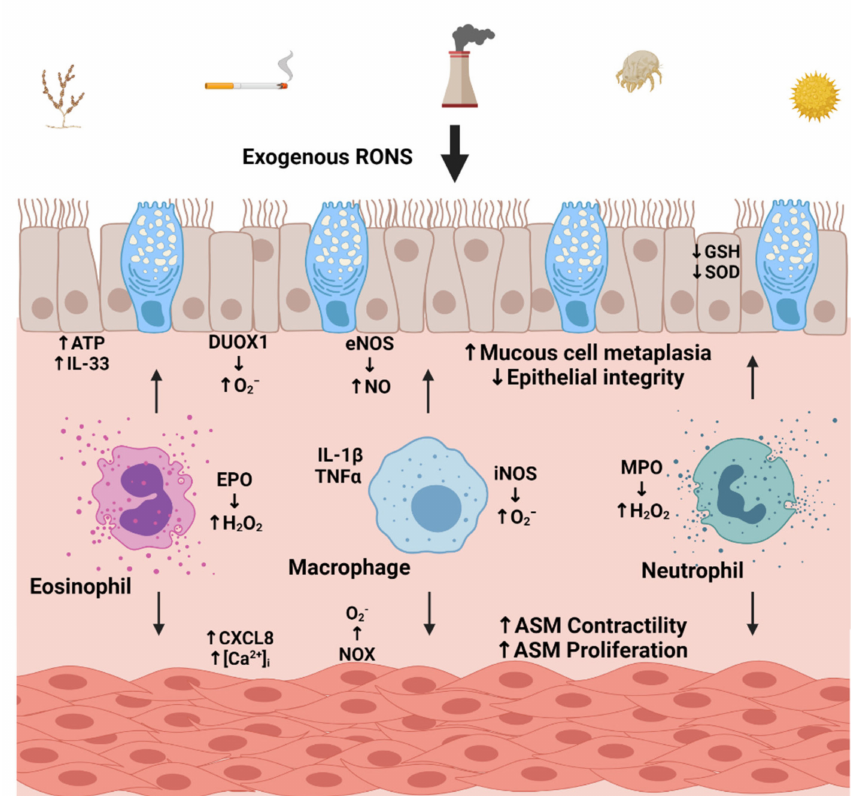
Figure 1. Effects of oxidative stress on airway inflammation. Environmental allergens, cigarette smoke, pollution, and pathogens interact with the airway epithelium, leading to increases in ex- ogenous or endogenous reactive oxygen and nitrogen species (RONS) levels and contributing to the pathogenesis of asthma and COPD. In response, the airway epithelium generates superoxide (O 2 − ) and nitric oxide (NO) and releases ATP and IL-33. Similarly, airway smooth muscle (ASM) release pro-inflammatory mediators such as CXCL8 and superoxide. In addition to loss in barrier integrity, the airway epithelium exhibits mucous cell metaplasia. ASM becomes hypercontractile and proliferates, leading to hypercontractility and airway thickening. Further, inflammatory cells such as eosinophils and neutrophils release eosinophilic peroxidase (EPO) and myeloperoxidase (MPO), respectively, in response to increased intracellular oxidative stress. EPO and MPO further contribute to increases in airway oxidative stress by generating hydrogen peroxide (H 2 O 2 ). Increased iNOS activity in macrophages also contributes to RONS and the release of inflammatory mediators. The activity of antioxidant mechanisms, such as the glutathione (GSH) system and superoxide dismutase (SOD), are dysfunctional and are found to be reduced in airway epithelial cells in severe asthma and COPD, further enhancing oxidative stress and airway inflammation. Created with “Biorender.com”. ( ↑ ) denotes increased levels and ( ↓ ) denotes decreased